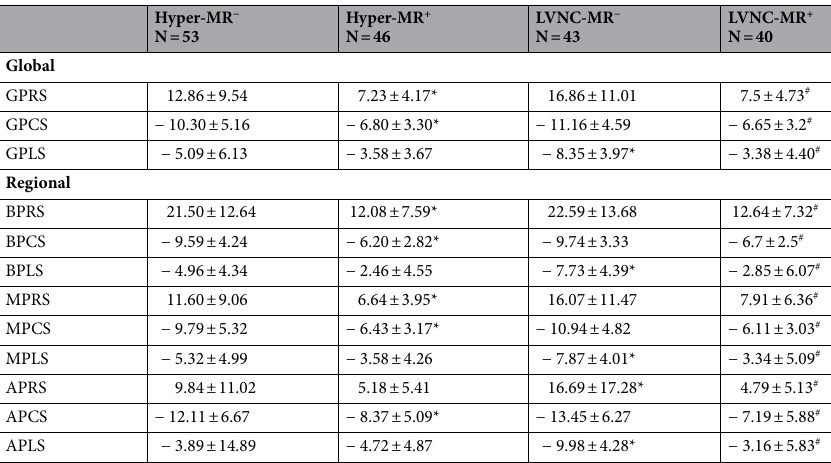
Table 3. The global and regional myocardial strain. *, vs Hyper-MR − ; # , vs LVNC-MR − . GPRS global peak radial strain, GPCS global peak circumferential strain, GPLS global peak longitudinal strain, BPRS basal peak radial strain, BPCS basal peak circumferential strain, BPLS basal peak longitudinal strain, MPRS middle peak radial strain, MPCS middle peak circumferential strain, MPLS middle peak longitudinal strain, APRS apical peak radial strain, APCS apical peak circumferential strain, APLS apical peak longitudinal strain.